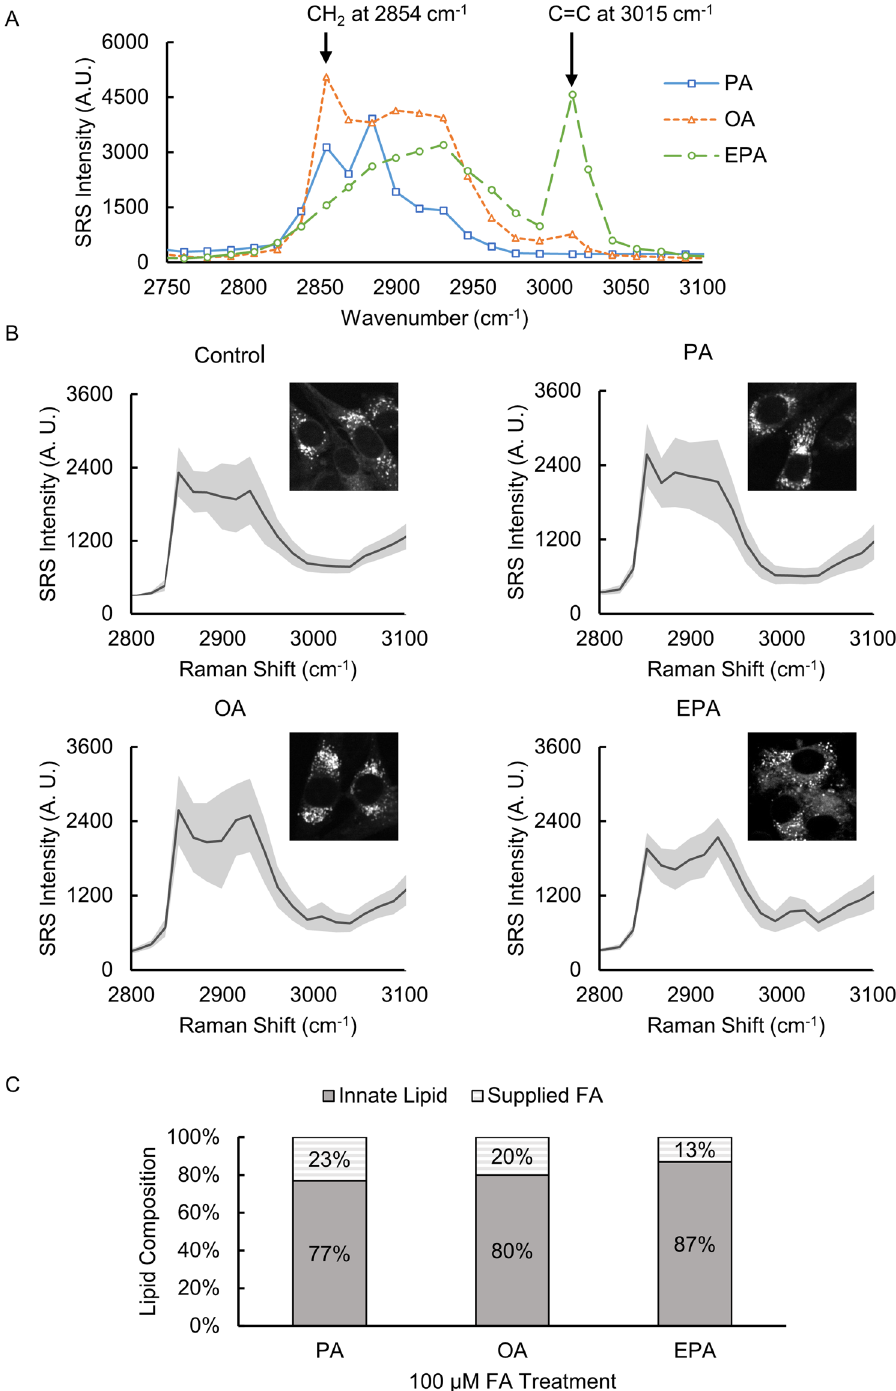
Figure 3. ( A ) SRS spectra of fatty acids PA, OA, and EPA. ( B ) Average SRS spectra of all LDs with diameters above 1 µm from SRS images of U87 glioma cells treated with PA, OA, and EPA at 100 μM for 24 h, respectively. The solid line shows the mean SRS intensity, and the gray area shows the standard deviation (SD). ( C ) The percent compositions of FAs in the LDs calculated through linear unmixing of the SRS spectra using the multiple linear regression (MLR) method. The adjusted R 2 was 0.972, 0.976, and 0.954, for PA-, OA- and EPA- treated LDs, indicating this was a well-fitting